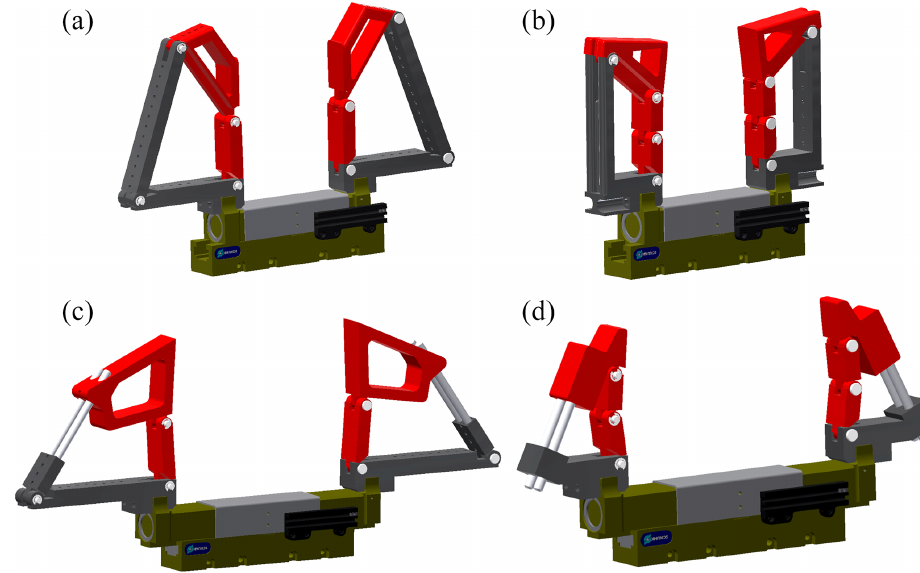
Figure 7. CAD models for the optimal designs of the fingers; the gripper is shown in the closed (a, b) and open (c, d) positions.